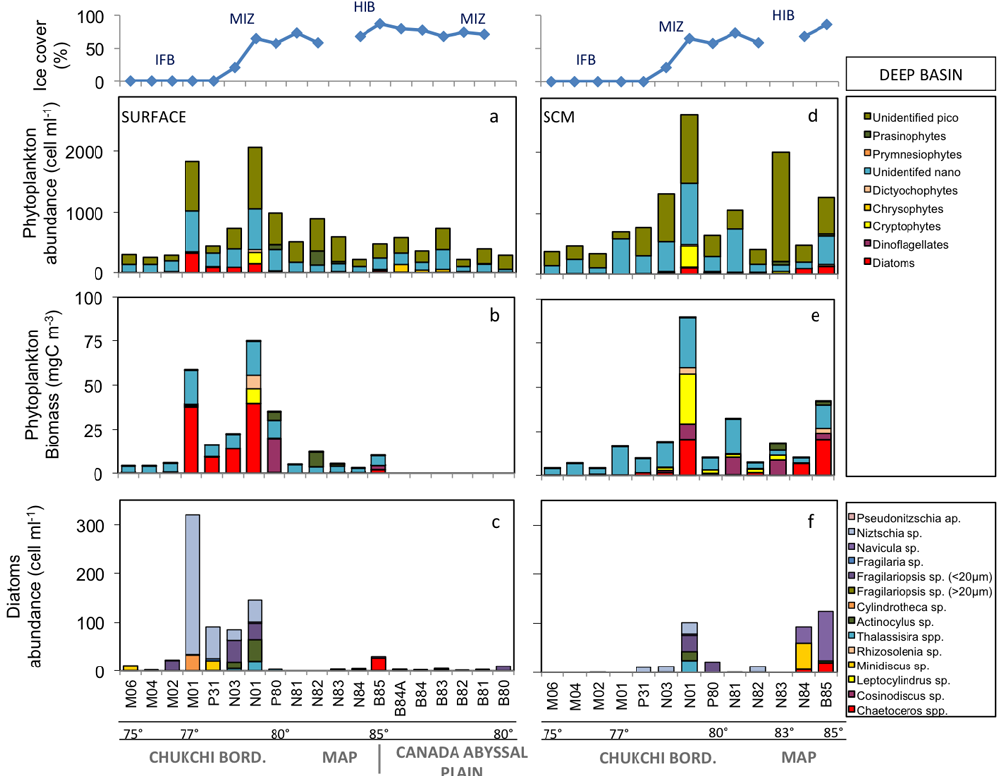
Fig. 5. Phytoplankton abundance and carbon biomass derived from microscopic counts in surface (left panels) and SCM (right panels) over the Chukchi Borderland, Mendeleev Abyssal Plain (MAP) and the Canada Abyssal Plain. The four upper panels show the abundance (a–d) and carbon biomass (b–e) of the major taxa. Two bottom panels (c–f) show the abundances of the 14 dominant centric and penate